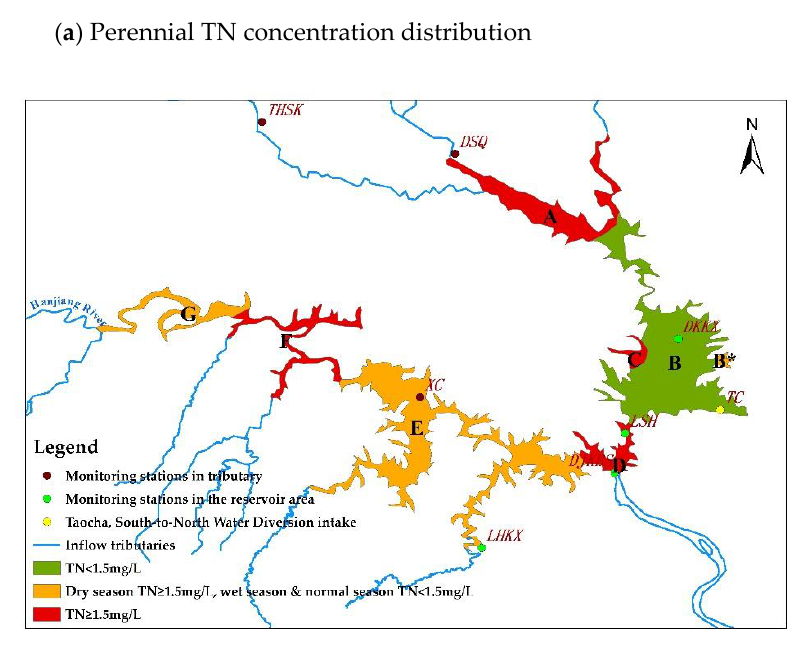
Figure 3. TN distribution in the Danjiangkou Reservoir (2009 –